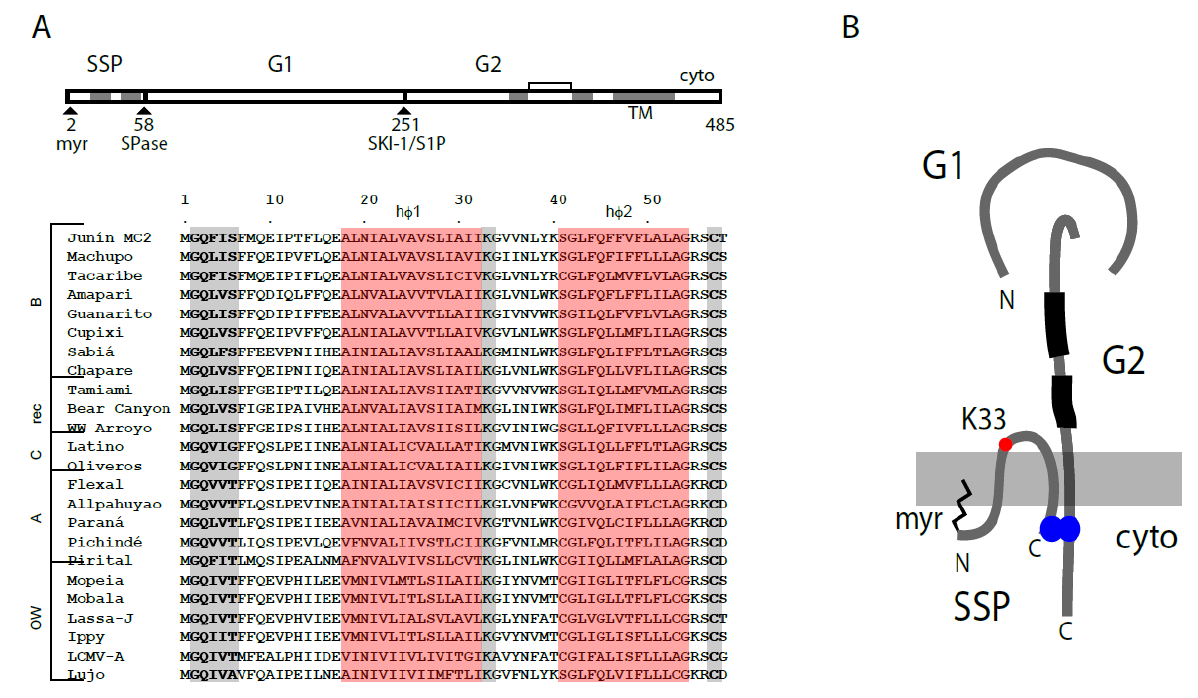
Figure 2. Schematic representation of GPC open-reading frame, stable signal peptide (SSP) sequence alignment and the tripartite GPC protein complex. ( A ) The GPC open-reading frame is diagrammed. Cleavage sites for signal peptidase (SPase) and subtilisin-like kexin protease-1/site-1-protease (SKI-1/S1P) are indicated, as are the mature SSP, G1 and G2 subunits. In SSP, the myristoylation at glycine 2 is marked, and the shaded regions denote the two hydrophobic regions (h  1 and h  2, highlighted in red in the sequence comparisons below). The transmembrane and cytoplasmic domains of G2 are indicated, as well as the two heptad-repeat regions (shaded) and disulfide-bonded hinge region. The sequence comparison of SSP among arenaviruses is adapted from [32], in which accession numbers are listed. In addition to h  1 and h  2 (red), the conserved myristoylation motif, K33 and C57 residues are highlighted in gray. ( B ) Schematic drawing illustrating the subunit organization of the tripartite GPC complex. The membrane is shown in gray. SSP spans the membrane twice, and salient features are indicated: Membrane association of the myristoylated N-terminus, K33 in the SSP ectodomain, and the intersubunit zinc-binding motif that bridges the C-terminal cytoplasmic domains of SSP and G2. The two heptad-repeat regions in the G2 ectodomain are depicted in black. The drawing is not to scale and the structural relationships among subunits is not